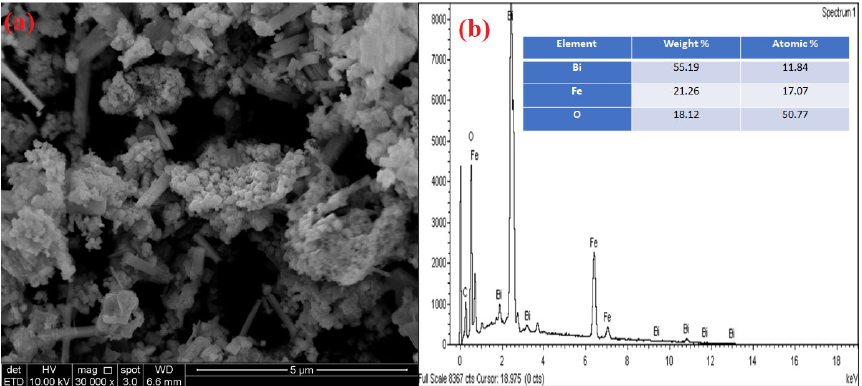
Figure 4. ( a ) SEM image of BFO NPs and ( b ) EDX spectrum of BFO.